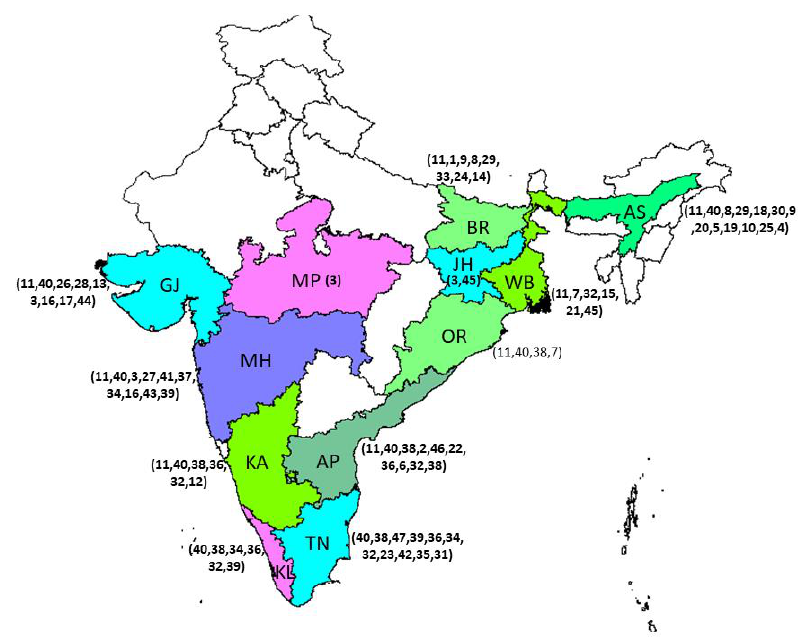
Figure 2. Distribution map of cultivated banana varieties in Indian states generated using DIVA-GIS (http://www.diva-gis.org/gdata accessed on 22nd November 2022). Adopted and modified from